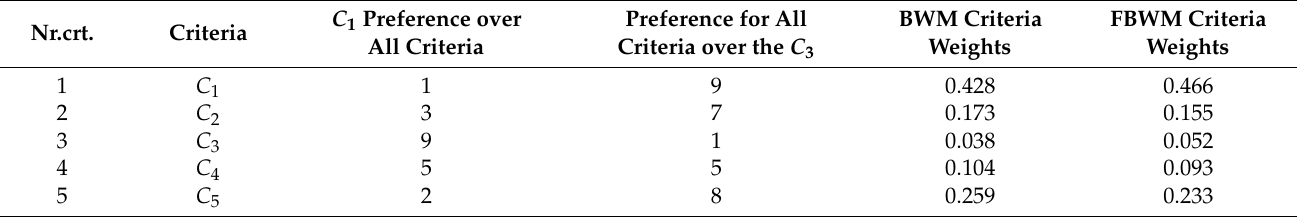
Table 2. Comparison between the SMD type criteria weights obtained with BWM and FBWM.